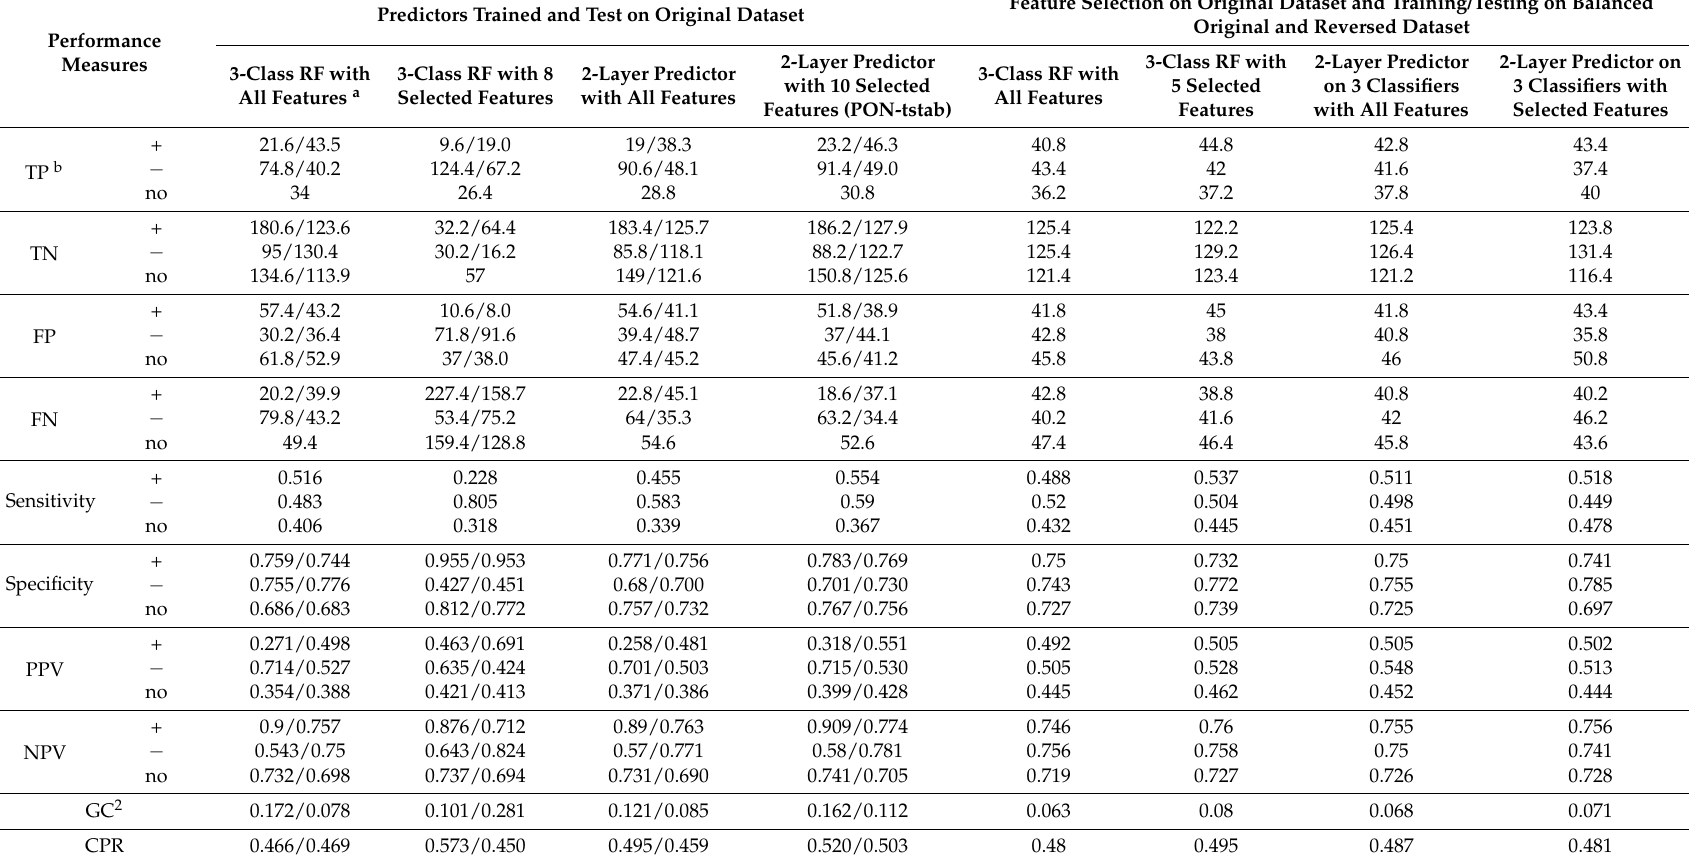
Table 1. Comparison of different classifier designs on five-fold